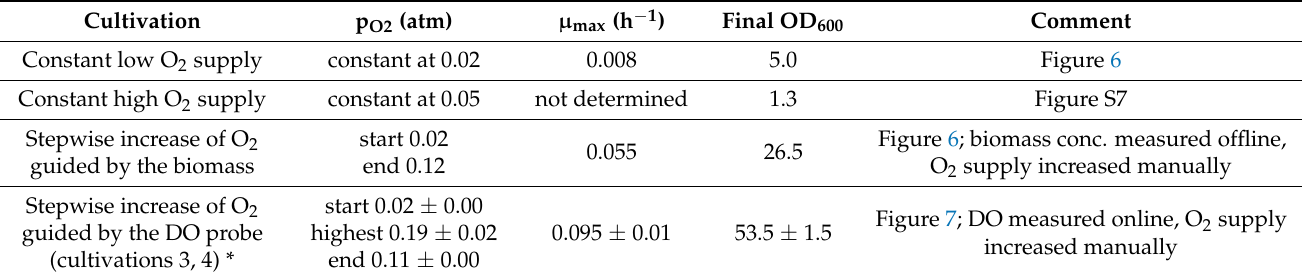
Table 3. Comparison of different O 2 supply strategies. Effect of starting p O2 and p O2 supply method.